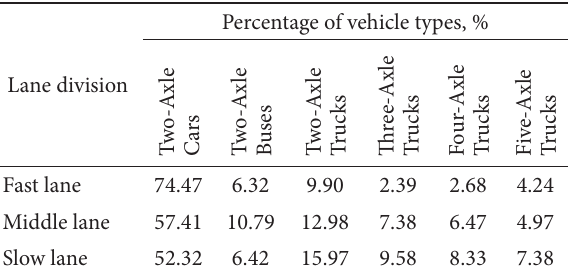
Fig. 2. Influence surface of cable stress under unit load Table 3. Proportions of different types of vehicles